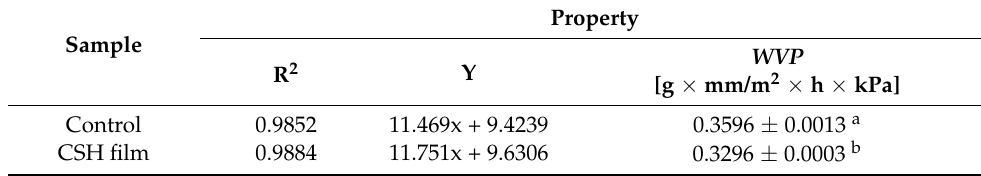
Figure 1. Weight increase plot as a function of time. Table 2. The results obtained for WVP.